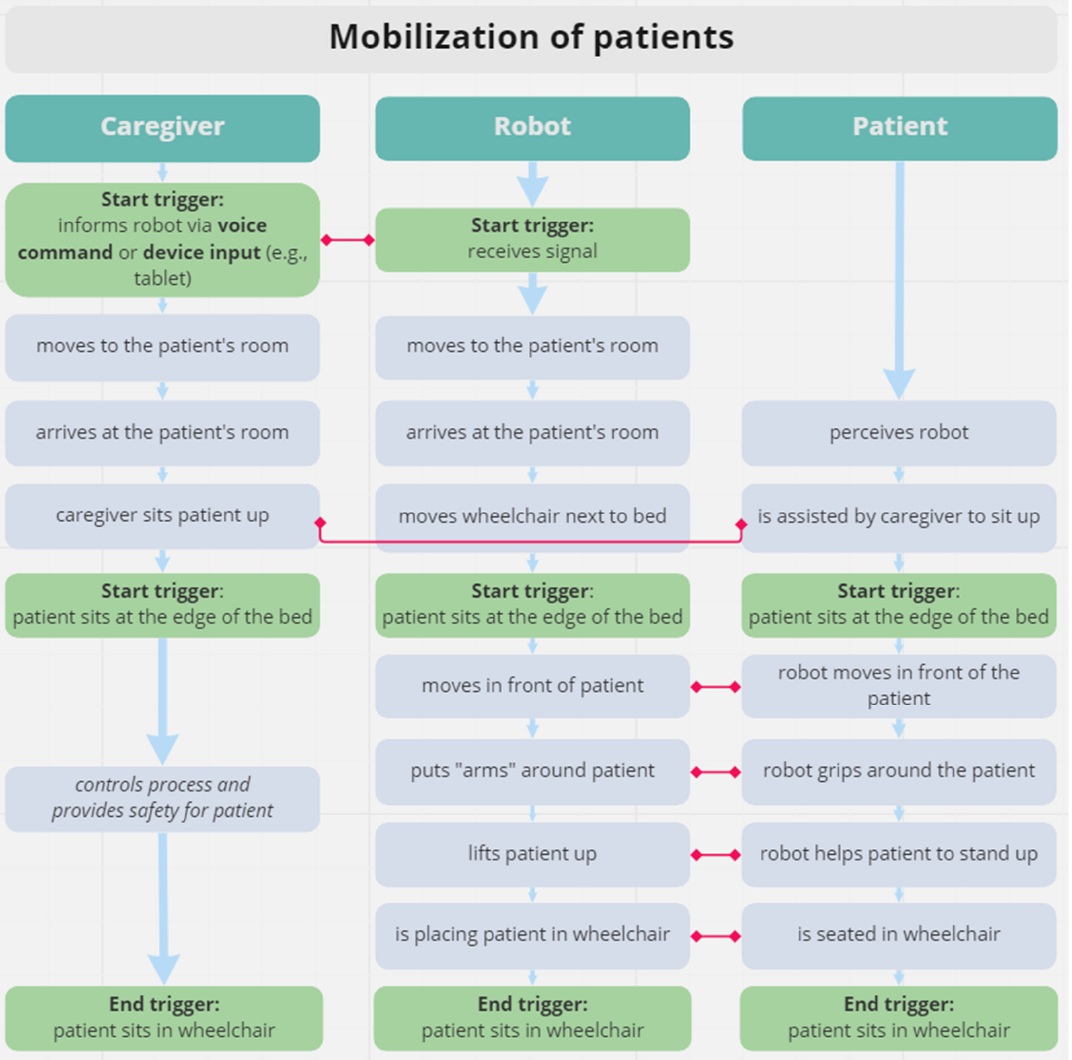
Figure 10. Sequence model of mobilization of patients. Figure 10 summarizes the results of the survey of healthcare professionals on their individual perceptions of the process of mobilization of a patient with robotic assistance. The illustration indicates that the process of mobilization by a robot involves specific abilities on the part of the patient in order to support the transfer. In this context, the authors emphasize that the characteristics of the robot as well as the mobilization procedure must be checked for patients with significant limitations in their motor